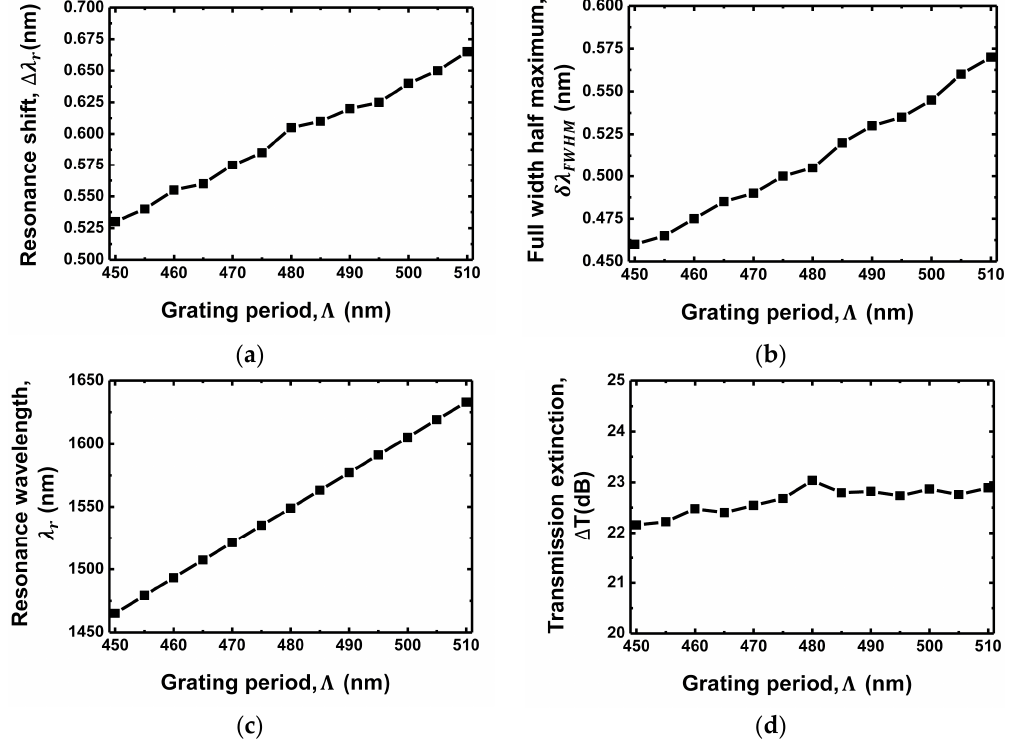
Figure 5. ( a ) Resonance wavelength shift ( ∆ λ r ; ( b ) FWHM ( δλ FWHM ); ( c ) Resonance wavelength ( λ r ); ( d ) Transmission extinction ( ∆ T) as functions of the grating period of the grating waveguide.